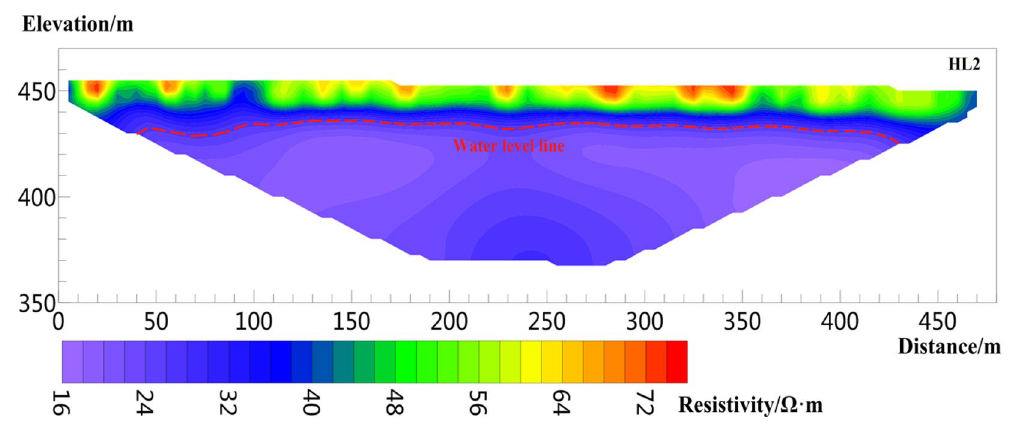
Figure 13. Resistivity profile of line